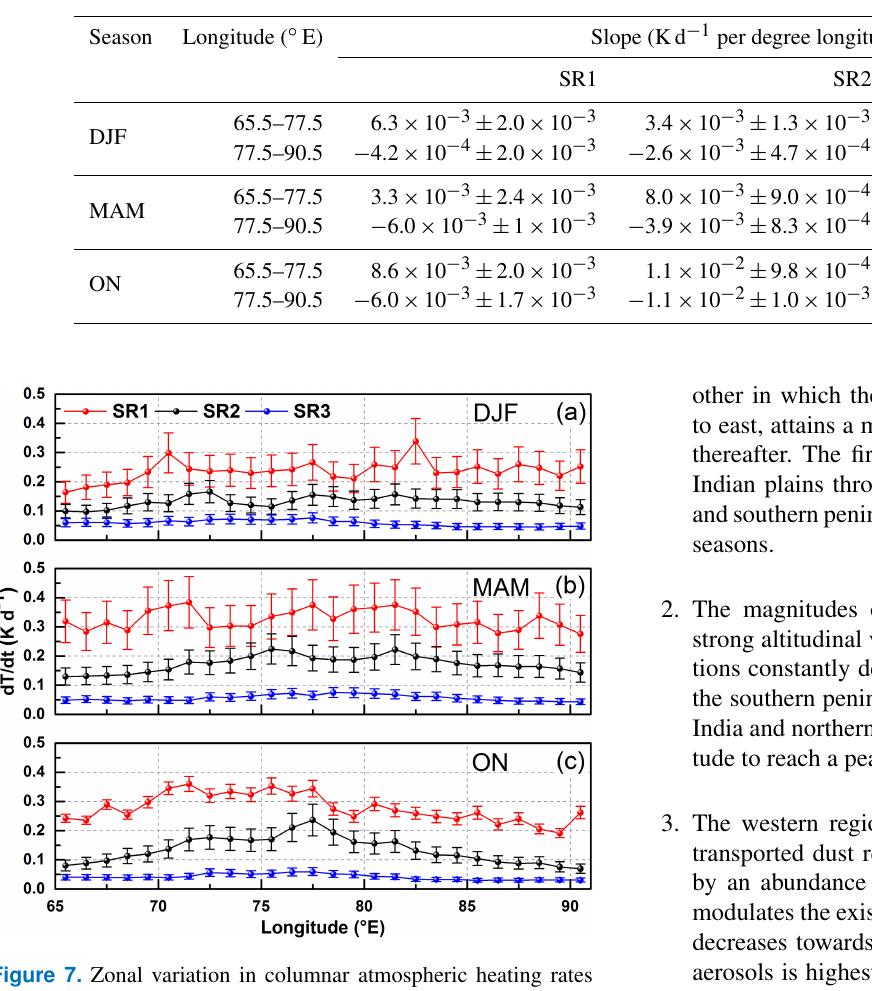
Table 4. Mean slope along with its standard error of the linear regression fits created to identify zonal variation in columnar atmospheric heating rates imparted by aerosols for all seasons and sub-regions.